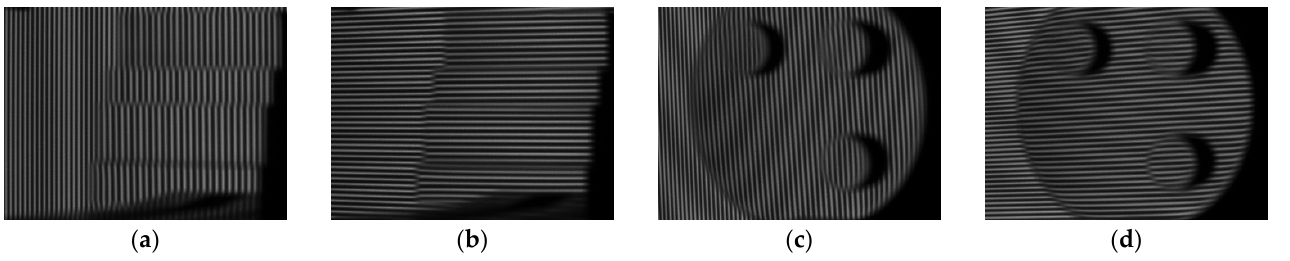
Figure 9. The deformed vertical and horizontal fringe patterns reflected by the structured specular surfaces: ( a , b ) rectangular